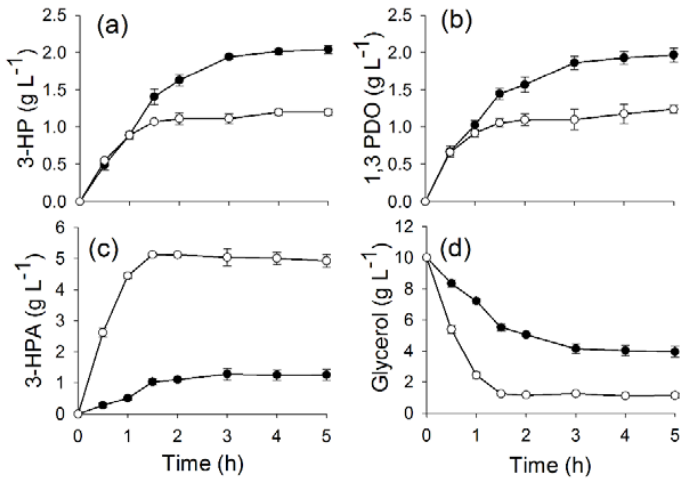
Figure 3. Kinetics of 3-HP ( a ), 1,3-PDO ( b ), and 3-HPA ( c ) accumulation in the extracellular medium and glycerol concentration ( d ) in the bioconversion medium during the bioconversion phase by L. reuteri , after growth on optimized medium (WE-LPS) (black circles) or MRS (blank circles). Mean values and standard deviation of three replicates.